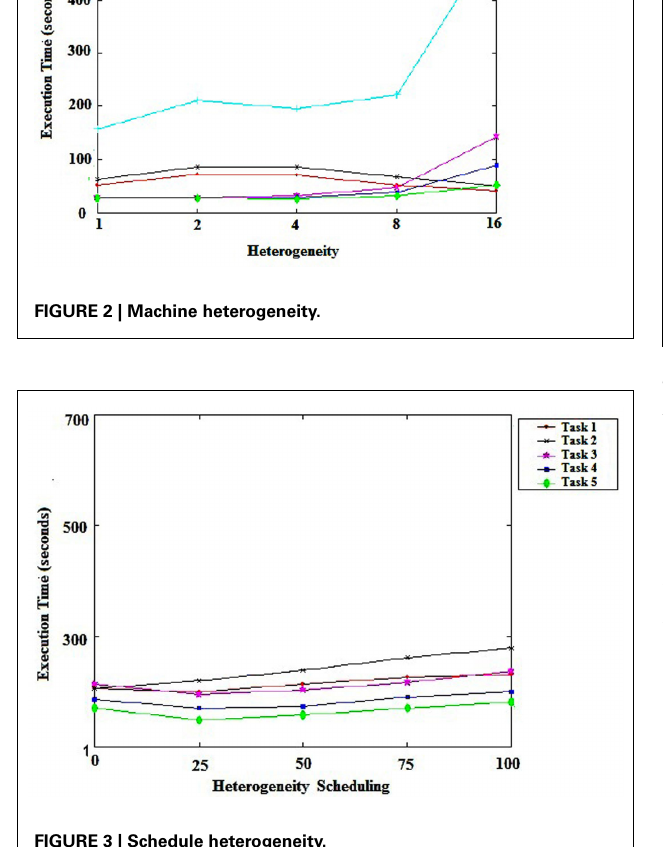
FIGURE 3 | Schedule heterogeneity.